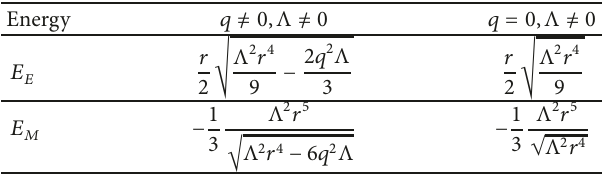
Table 2: Energy of the massless ( 𝑀 = 0 ) black hole solution in the Einstein and Møller